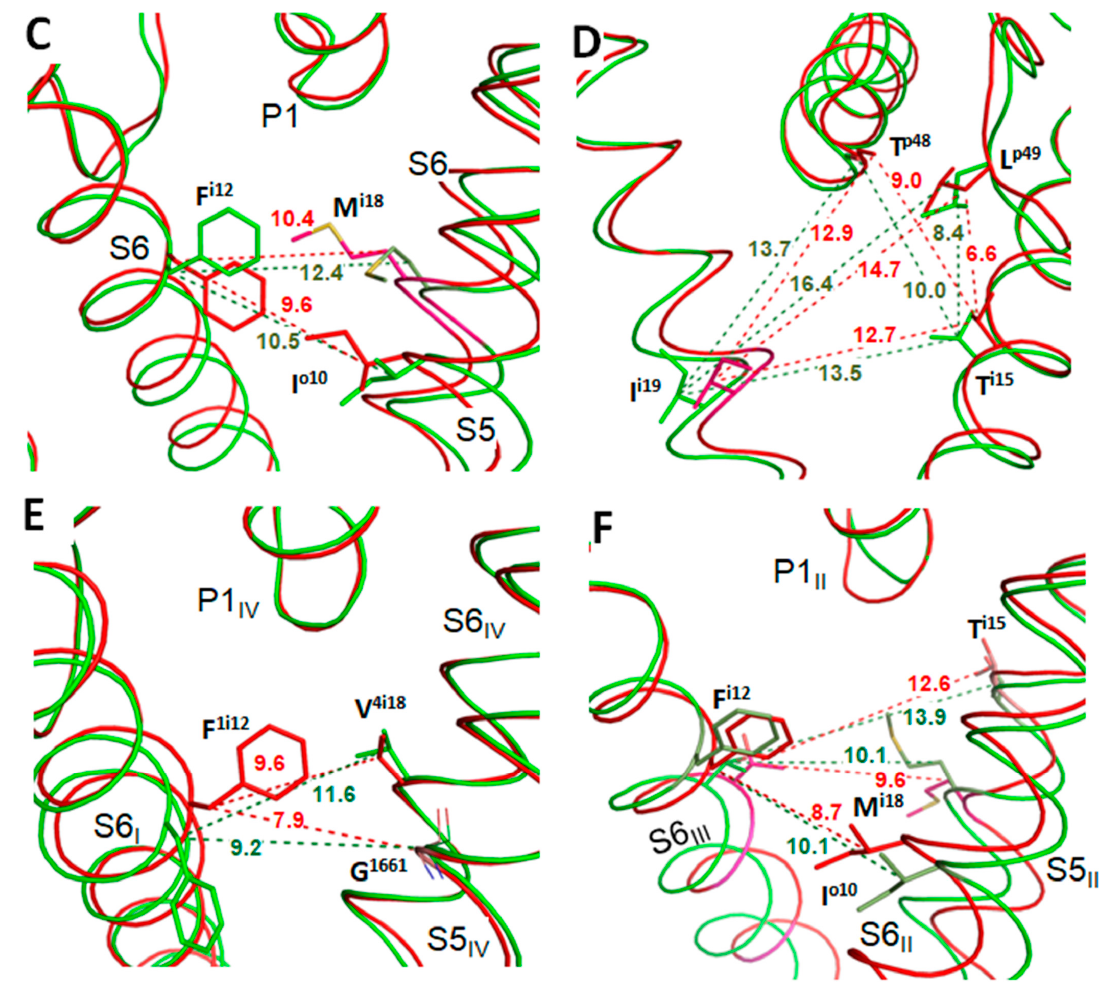
Figure 4. Deactivation of VSDs narrows fenestrations in the pore domain. Channels are viewed from lipids along helix P1 (panels A – C , E , F ) or from the pore axis (panel D ). Distances (Å) are shown between C β atoms (C α atom in glycine). In panels ( C – F ), structures with the activated and deactivated VSDs are green and red, respectively. ( A ) Cryo-EM structure of hNav1.5. ( B ) hNav1.5 model with in silico deactivated VSD III . ( C ) NavAb crystal structure with activated VSDs (PDB ID: 6p6x) and deactivated VSDs (PDB ID: 6p6w). ( D ) Structures from panel C viewed from the pore axis. Sticks show side chains of residues, which are in sequentially matching positions with experimentally known MEX-sensing residues in Nav1.5, as well as the backbone carbonyl T p48 . Activation of VSDs increases the room where MEX bind in eukaryotic Navs. ( E ) Cryo-EM structures of the rNav1.5 channel in the apo form (PDB ID: 6uz3) and with tarantula toxin bound to VSD IV (PDB ID: 7k18). Residues are numbered as in hNav1.5. ( F ) Fenestration II/III in the cry-EM structures of the chimeric NavAb/Nav1.7 channel in the apo state (PDB ID: 6N4Q) and with gating-modifier spider toxin (PDB ID: 6N4R)